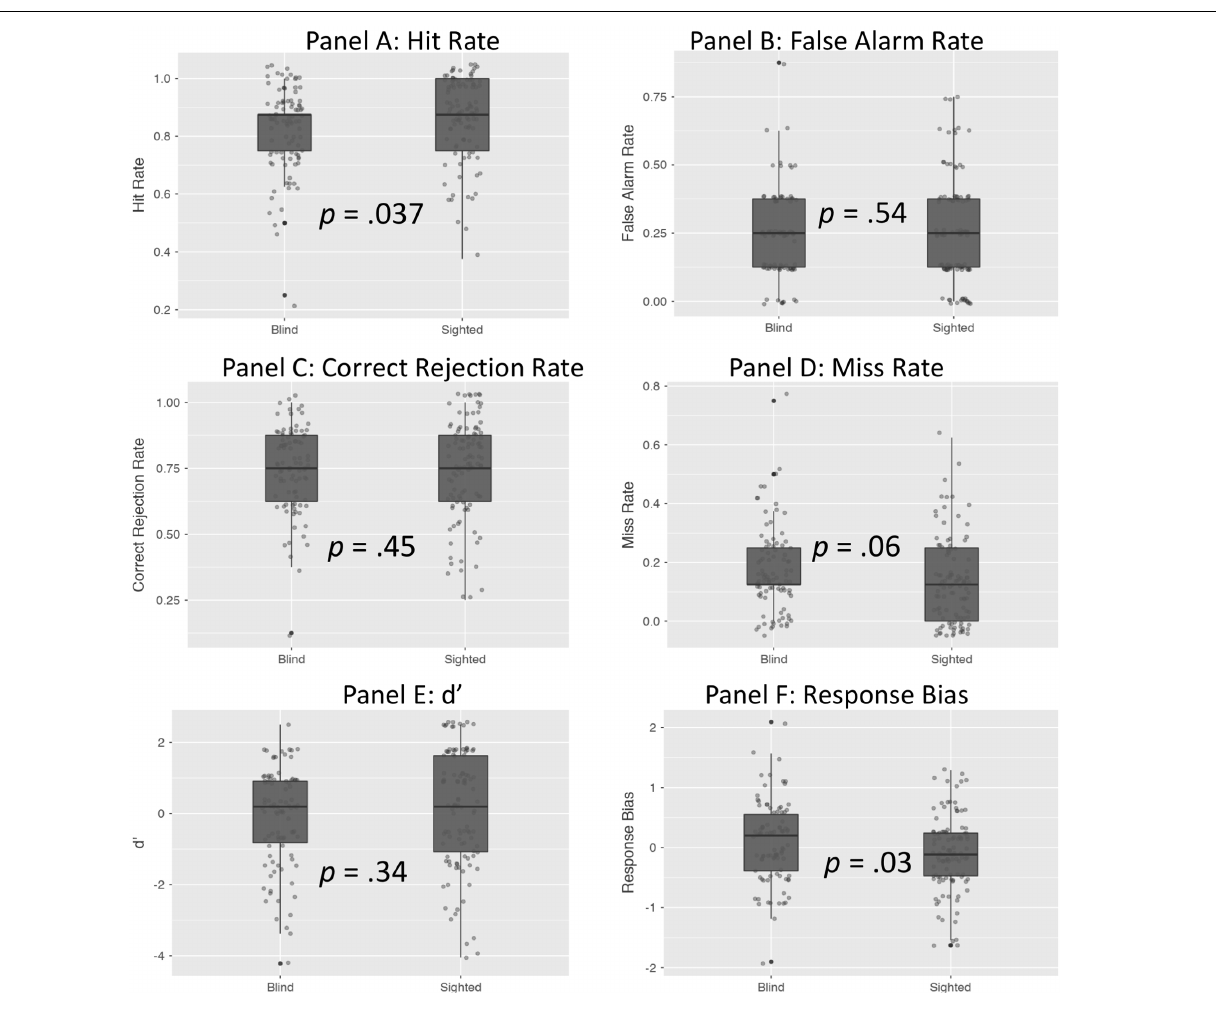
FIGURE 2 | The difference between blind and sighted individuals in recognition memory scores